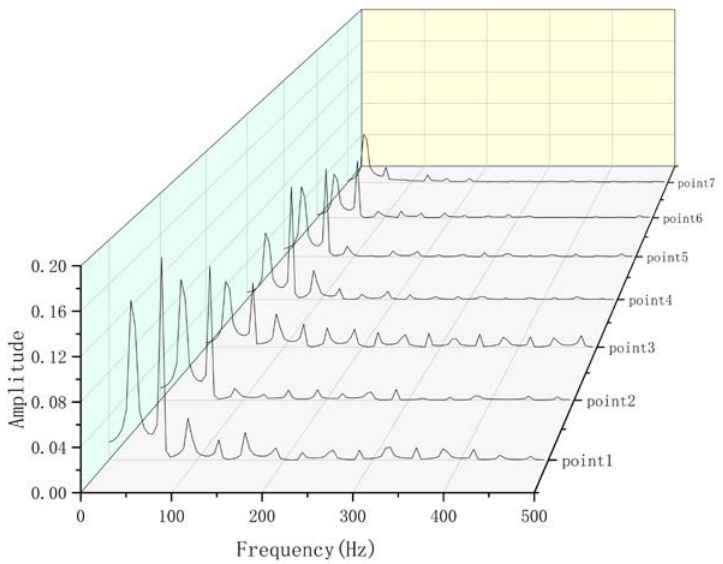
Figure 20. Pressure fluctuation in the area of hose recovery deformation calculated in the frequency domain when the outlet pressure is 0.1